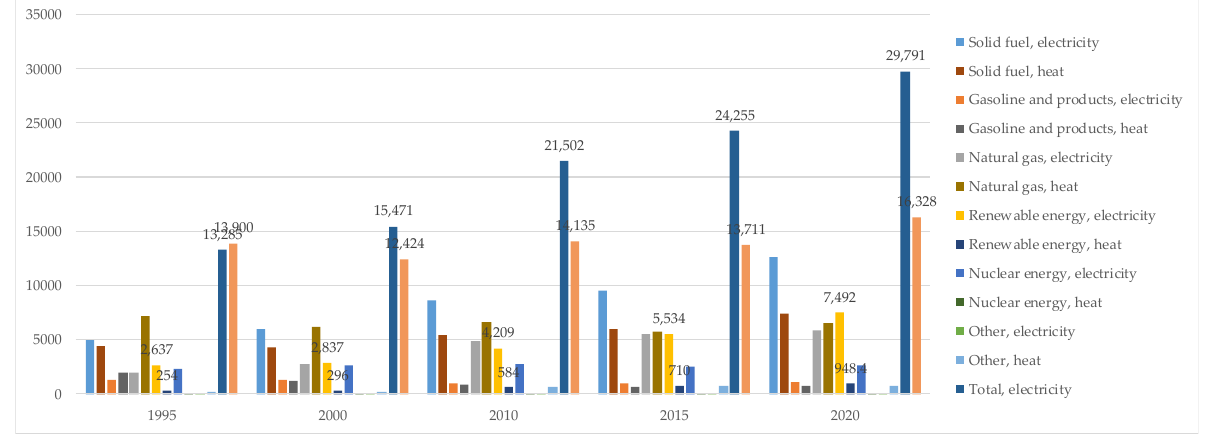
Figure 1. The global production of electricity/heat by resources. In 2020, the employment of all types of energy resulted in the generated 29.791 TWh of electricity and 16.328 PJ of thermal energy, 12.587 TWh and 7.398 PJ of which, respectively, were produced using solid fuel. The EU figures show that solid fuel consumption has fallen from 22% to 18% since 1995 due to an increase in energy from recycling and renewable energy. Fuel diversification has also led to a reduction in the consumption of fuel products and fuel itself [2,6,9].